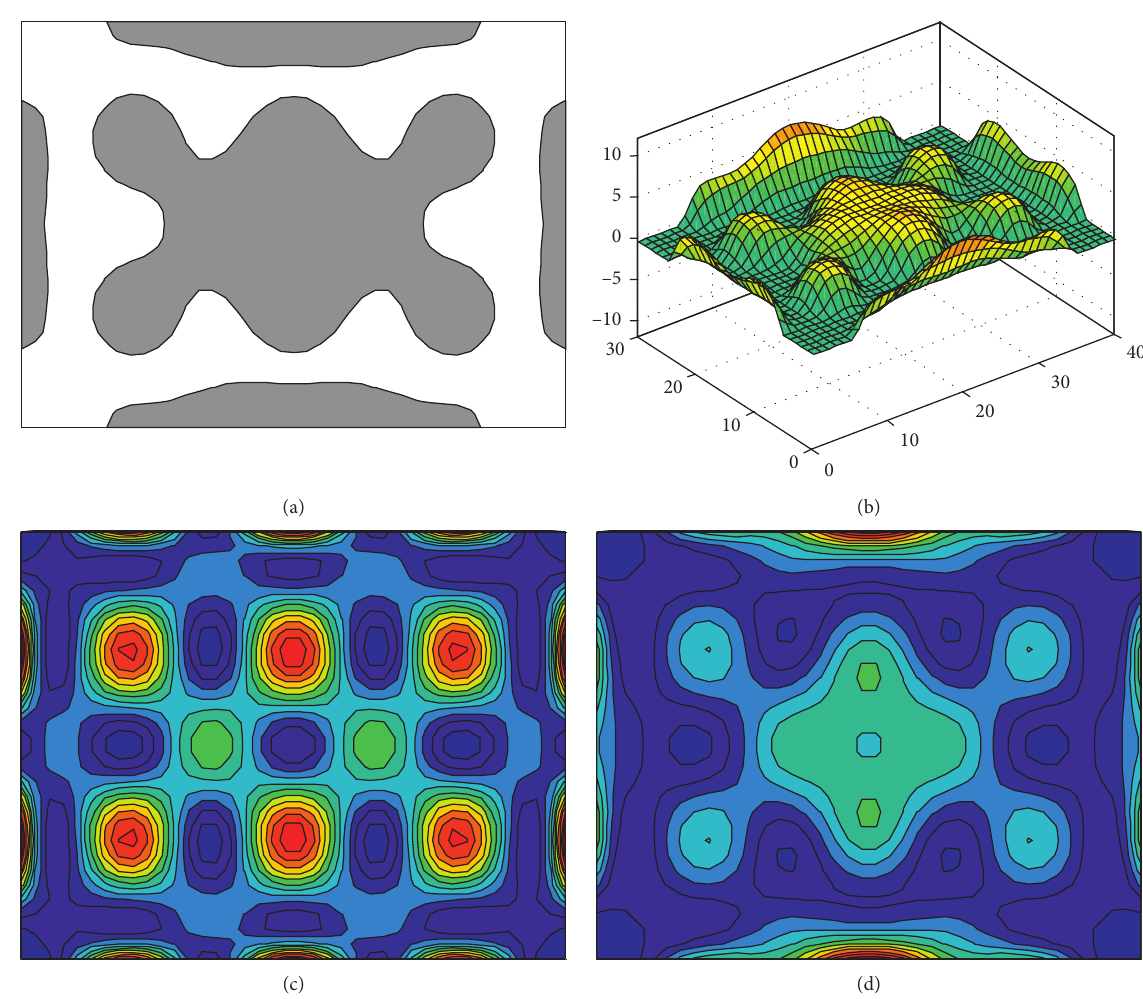
Figure 17: (a) Optimized result for the 1st and 6th modals, (b) corresponding level set surface of Figure 11(a), (c) MSE 1st and 6th modals, and (d) MSE normalized contour for the 1st and 6th total